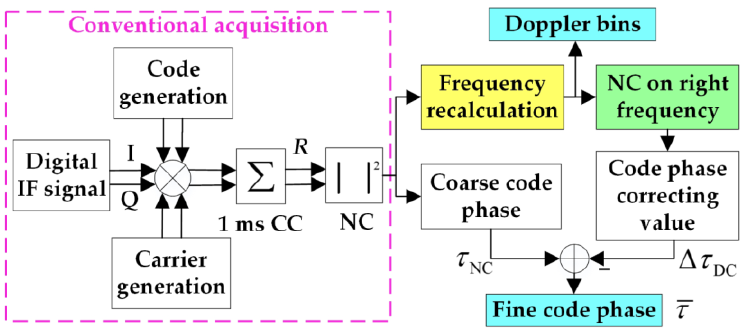
Figure 7. The diagram of the simulation platform.